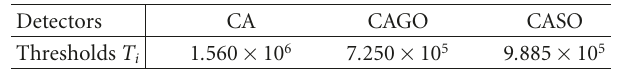
Table 1: The threshold multipliers T i of the detectors CA, CAGO, and CASO.